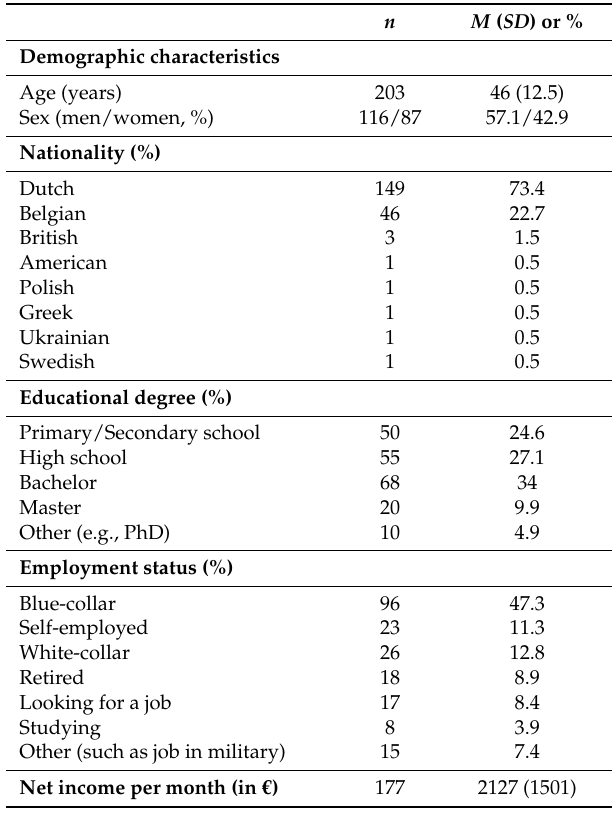
Table 1. Sociodemographic characteristics (mean ( SD ) or %). n M ( SD ) or